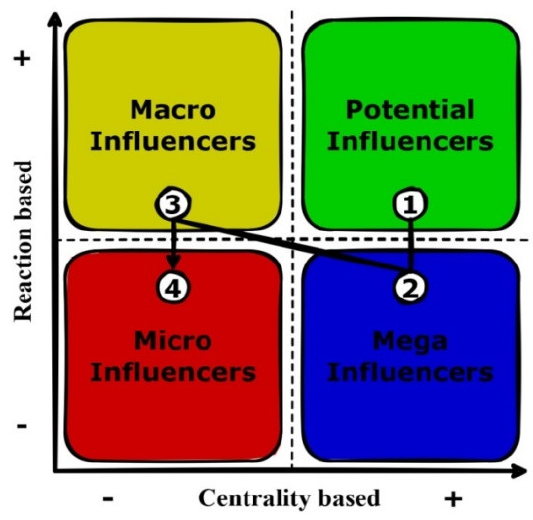
Figure 7. Opinion holders’ classification based on their influence level.